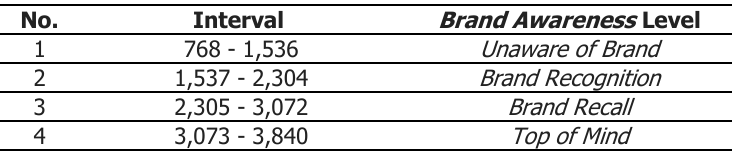
Table 2. Class interval table and brand awareness